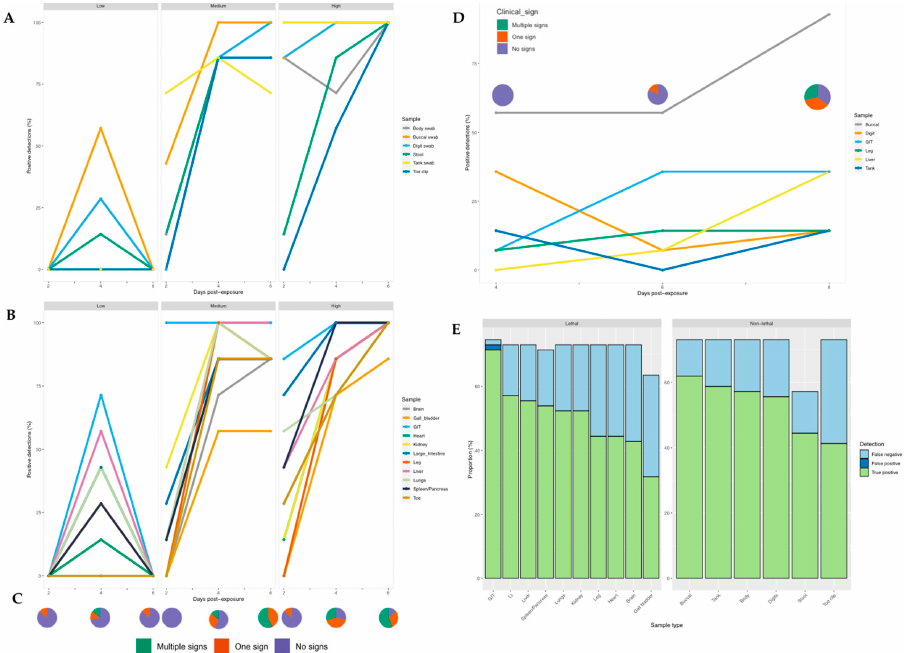
Figure 4. Proportion of samples positive for ranavirus for each individual sampling technique at different time points post-exposure in R. temporaria (left and bottom right) and B. bufo (top right). ( A ) Non-lethal and ( B ) Lethal sampling post-exposure for each ranavirus dose. ( C ) Clinical signs observed post-exposure across the low, medium and high dose treatment groups. ( D ) Non-lethal and lethal sampling post-exposure in toads. ( E ) Proportion of results that were true positives, false positives and false negatives for non-lethal and lethal ranavirus sampling in frogs. Viral Load: When we examined the effect of tissue type on viral load, the gastroin- testinal tract had a significantly higher viral load then all other tissue types except the lung ( p < 0.01) (Figure 5). Viral load overall varied significantly between all ranavirus treatment groups ( p < 0.01) and sampling days ( p < 0.03). Within the low dose treatment, tissues with the highest viral load included the lung and heart. In the other treatment groups, the lung